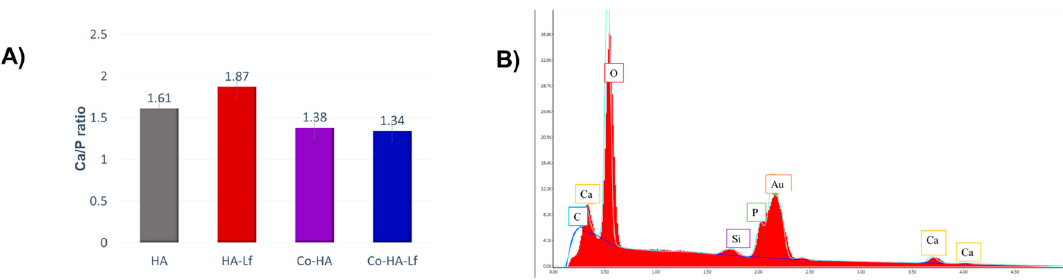
Figure 1. ( A ) Ca / P ratio of composite coatings obtained by Matrix Assisted Pulsed Laser Evaporation technique (MAPLE), ( B ) energy dispersive X-ray (EDX) spectra of hydroxyapatite (HA) coating obtained by MAPLE.